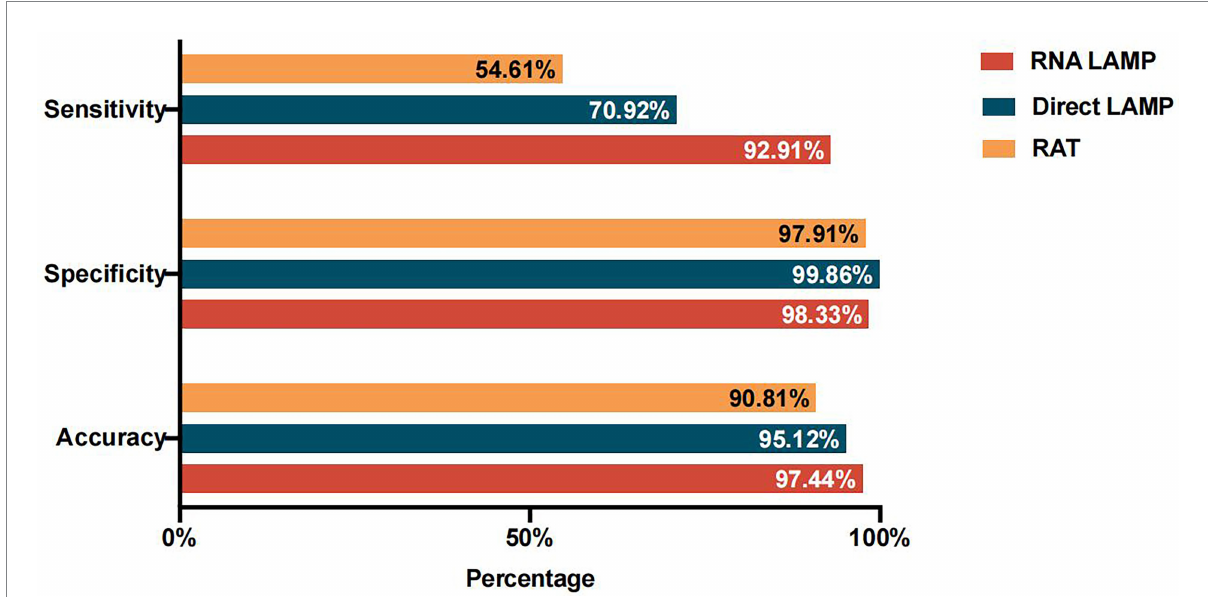
FIGURE 2 Diagnostic performance of the RNA-LAMP assay, direct LAMP assay, and